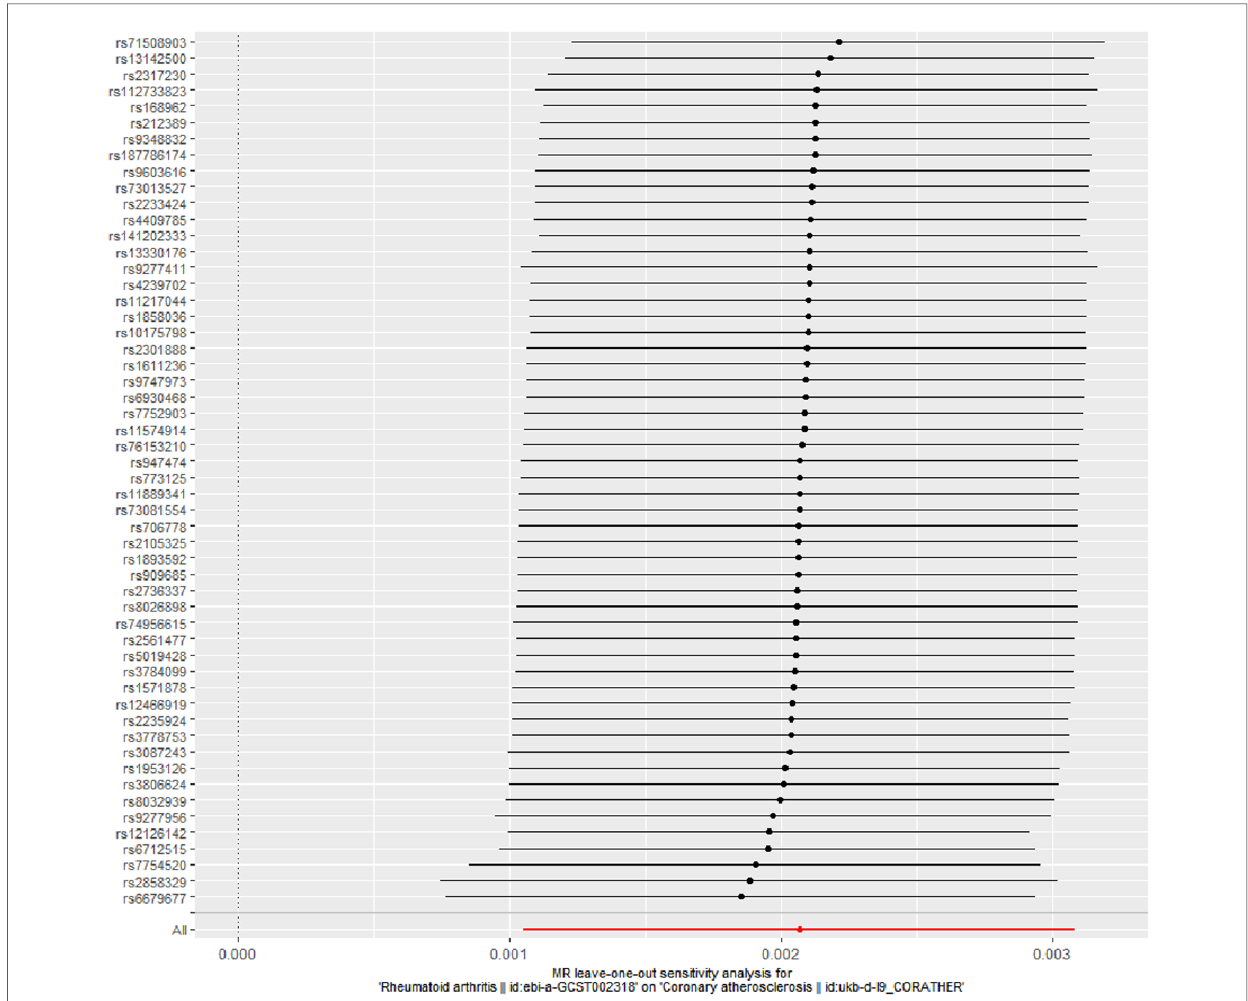
FIGURE 5 “ Leave-one-out ” analysis for RA on coronary atherosclerosis. “ Leave-one-out ” analysis of the causal effect of RA on coronary atherosclerosis susceptibility. Each black point represents the IVW effect estimate for the SNPs remaining after excluding individual SNP in turn, and the black line represents the corresponding 95% CI for the IVW effect estimate. The red point represents the IVW estimate using all SNPs. RA, rheumatoid arthritis; IVW, inverse variance weighted; SNPs, single nucleotide polymorphisms; CI, con fi dence